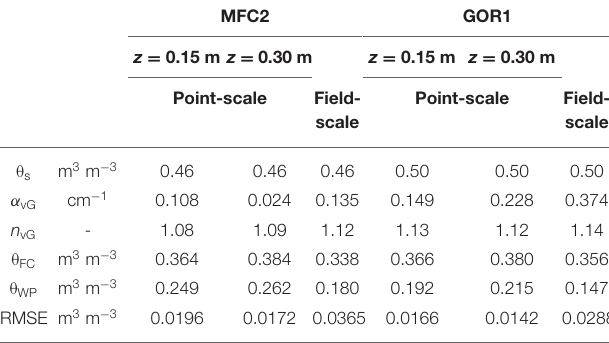
TABLE 4 | Parameters feauturing in the vG-WRF at MFC2 and GOR1 referring to point-scale SoilNet based WRF at soil depths of 0.15 and 0.30m and field-scale